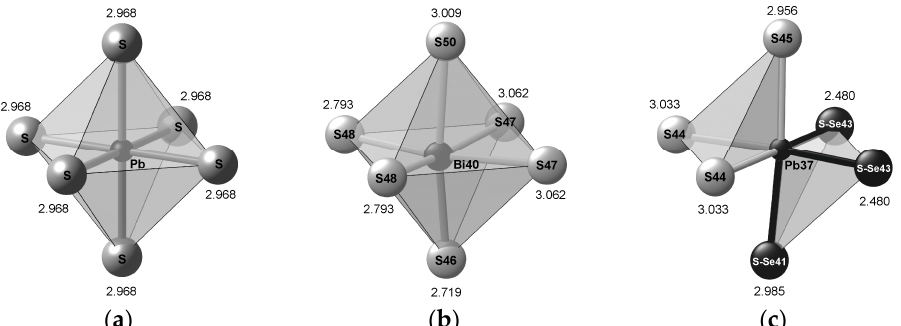
Figure 1. Examples of coordination polyhedra: ( a ) regular coordination octahedron in galena (AMCSD 0011372 and reference therein); ( b ) irregular homoligand octahedron around the Bi40 position in cannizzarite (Topa et al. [21]); ( c ) irregular heteroligand octahedron around the Pb37 in the same crystal structure, with two homoligand subpolyhedra defined for pure S and mixed S-Se ligands. The values near the octahedra’s vertices are bond lengths in ångstroms.